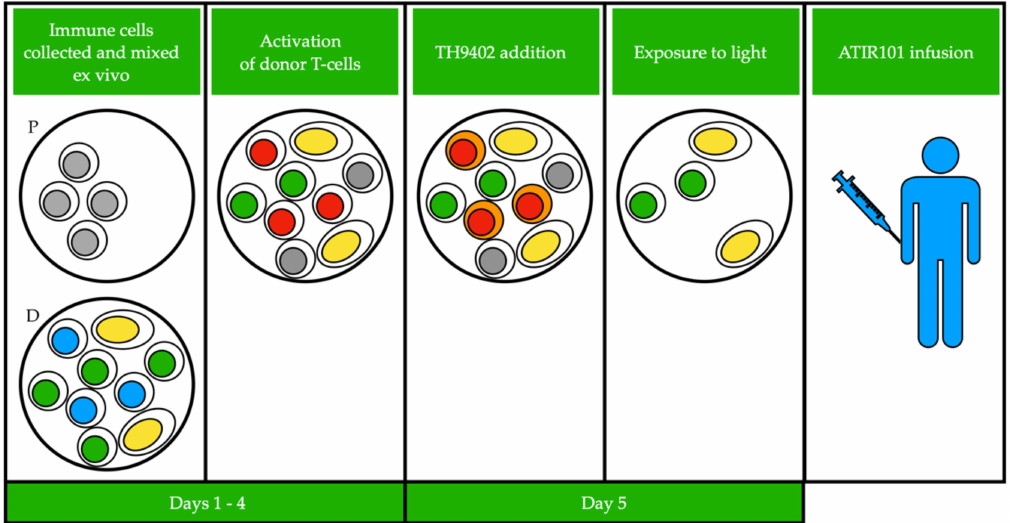
Figure 1. Photodynamic treatment (PDT) of the graft consists of a first phase in which donor and patient peripheral blood mononucleated cells are collected by apheresis. Then, patient cells are gamma-irradiated and donor and patient cells are co-cultured to stimulate activation of host alloreactive T-cells. GvHD causing T-cells from the donor are activated by the presence of “foreign” cells from the patient. TH9402, a photosensitizing reagent, is added to the culture and is retained only in activated donor T-cells. This mixture is then exposed to light, which activates TH9402 leading to production of oxygen radicals, resulting in self-destruction of GvHD causing donor T-cells. The remaining mixture (named ATIR101) is then infused into the patient. Color of the nucleus indicates di ff erent cell types: grey, irradiated patient cells; green, virus-specific T cells; blue, inactivated GvHD causing donor T cells; red, activated GvHD causing donor T cells; yellow, other immune cells (e.g., NK cells). Cells that retain the TH9402 reagent have orange colored cytoplasm. P: patient, D: donor. DLI is associated with a 10% mortality rate and may cause pancytopenia in 20% of